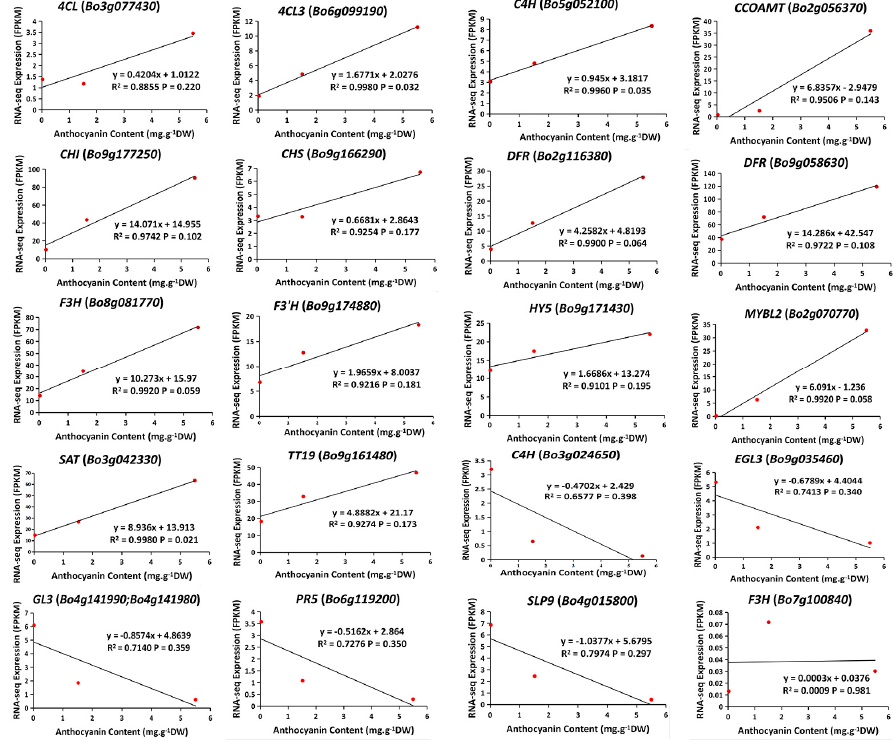
Figure 6. Correlation analyses between the relative expression levels of the genes and anthocyanin accumulation. Each panel represents a separate DEG.